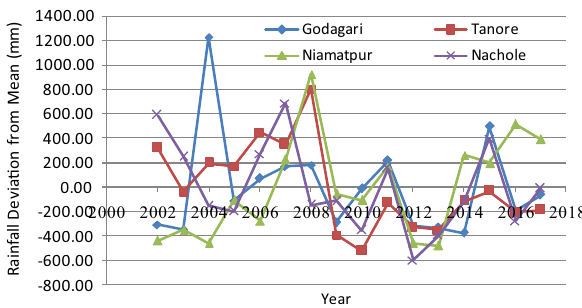
Fig. 10 Rainfall deficiencies from mean values and poor rainfall years in the study